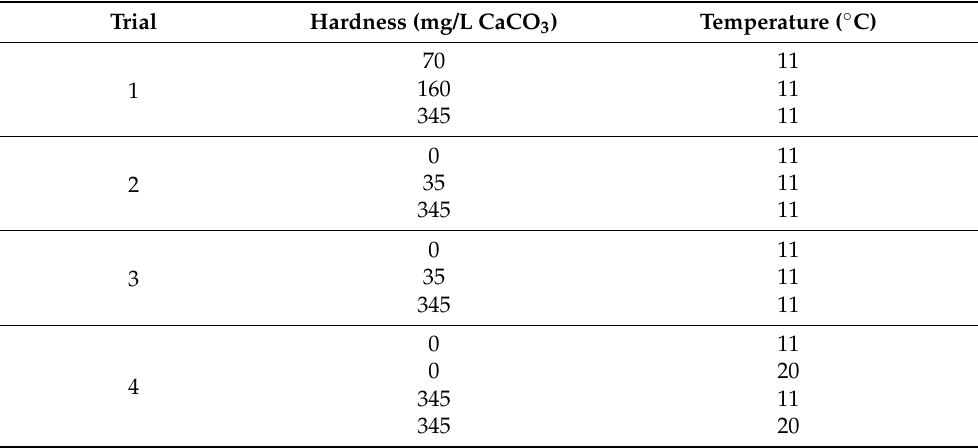
Table 1. Experimental design for each of the trials conducted in this study. Trial 1 and 2 used Shasta strain juvenile rainbow trout Oncorhynchus mykiss (mean ± SD, total length 203 ± 14 mm, weight 90.7 ± 17.2 g, n = 4). Trial 3 and 4 used Arlee strain juvenile rainbow trout (mean ± SD, total length 66 ± 6 mm, weight 2.9 ± 0.9 g, n = 4). All fish were directly transferred from a common pool at 11 ◦ C and hardness of 345 mg/L CaCO 3 . Trial Hardness (mg/L CaCO 3 ) Temperature ( ◦